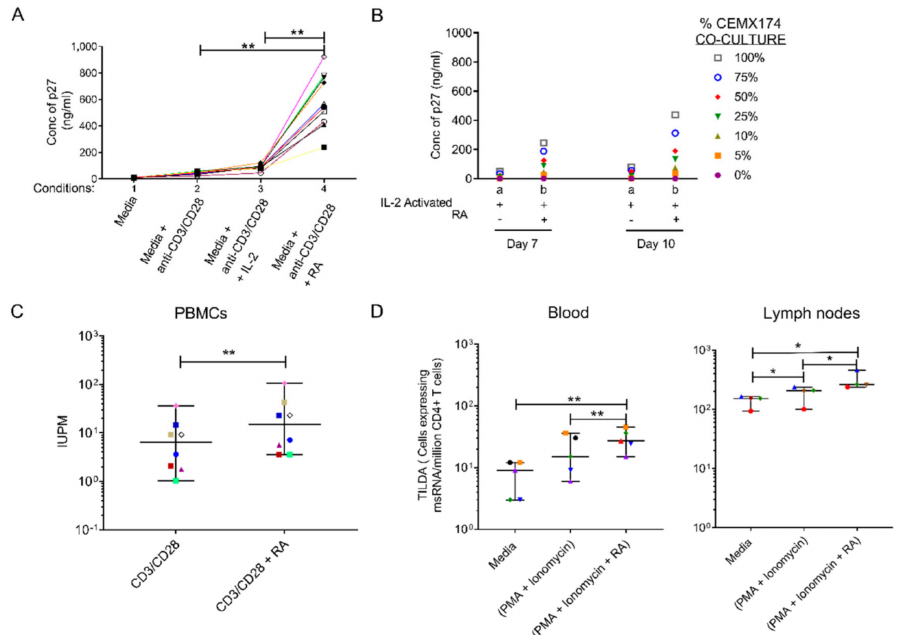
Figure 7. Retinoic Acid (RA) enhances viral replication in vitro and improves detection of the viral reservoir . ( A ) Levels of p27, a regulatory protein produced by HIV/SIV-infected cells [94], were measured in supernatant of peripheral blood mononuclear cells (PBMCs) from 10 randomly selected naive rhesus macaques (RMs). The PBMCs were infected with SIVmac239 after in vitro culturing with (1) media, unstimulated (2) anti-CD3/CD28 beads to activate the T-cell receptor (3) anti-CD3/CD28 + IL-2 (10 U/mL) and (4) anti-CD3/CD28 beads + IL-2 together with RA (1 µ M) added under separate conditions on day 10. ( B ) Levels of p27 detected in